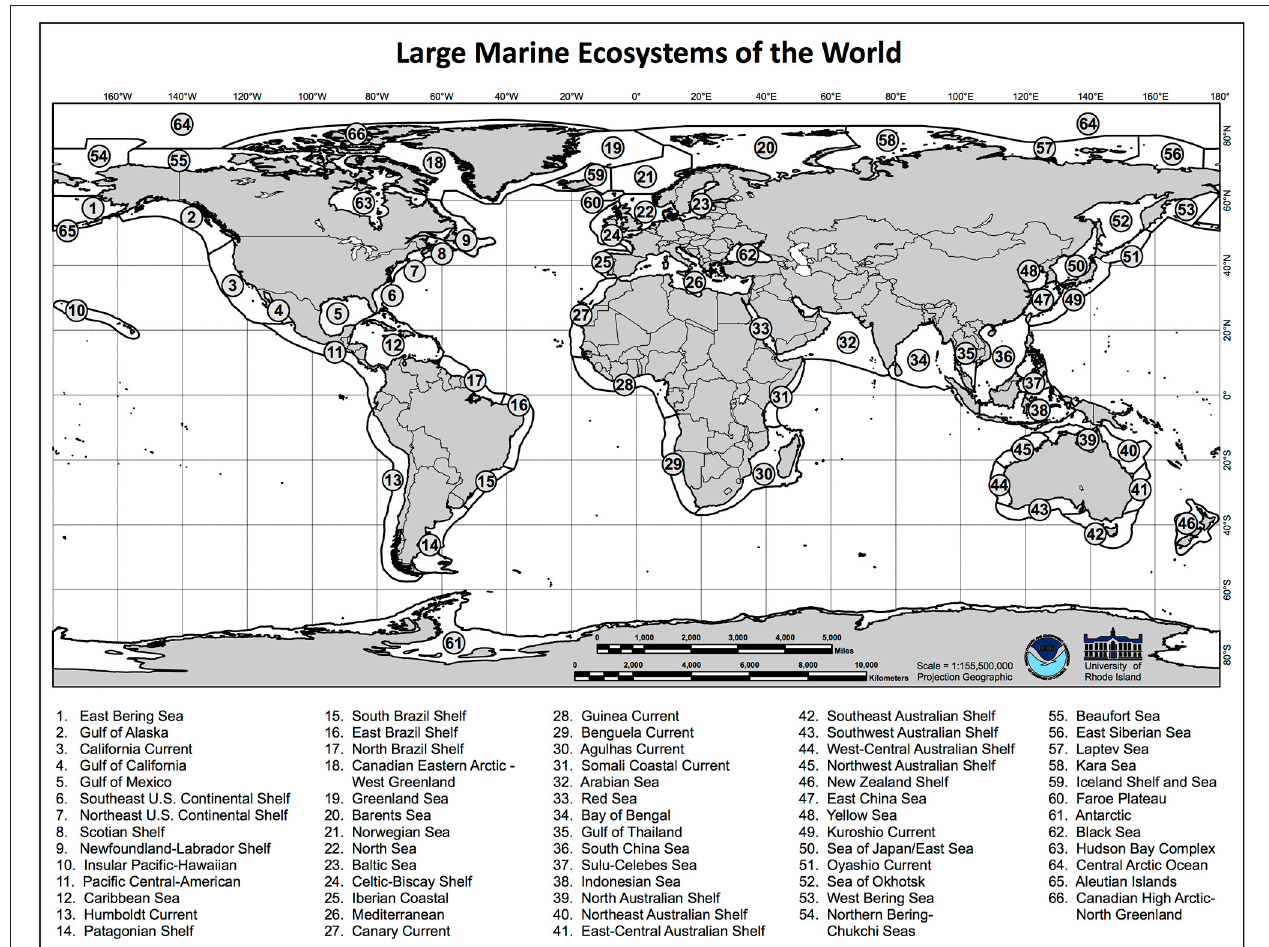
FIGURE 1 | Global map of Large Marine Ecosystems (LMEs). Image Credit: NOAA Large Marine Ecosystem Program. No permission was required from the copyright holder for the preproduction of this image.